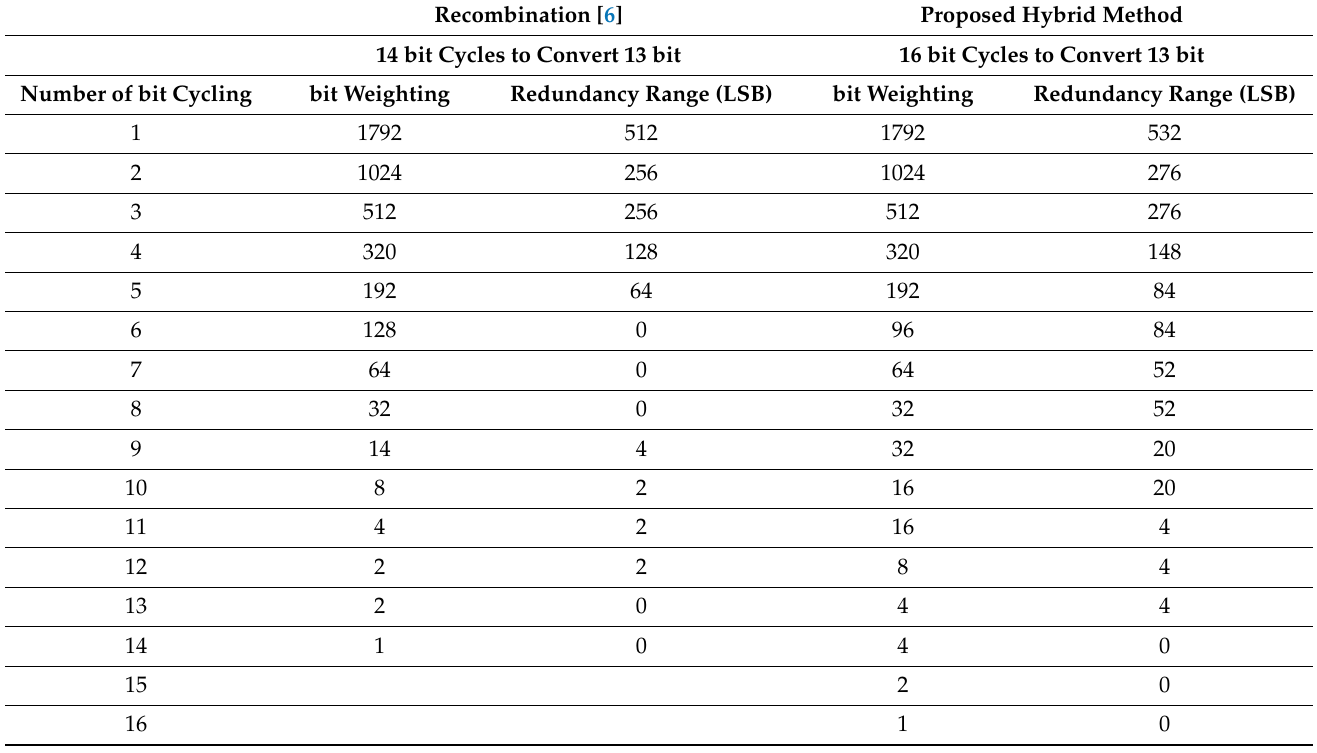
Table 1. Comparison of redundant ranges with different redundant